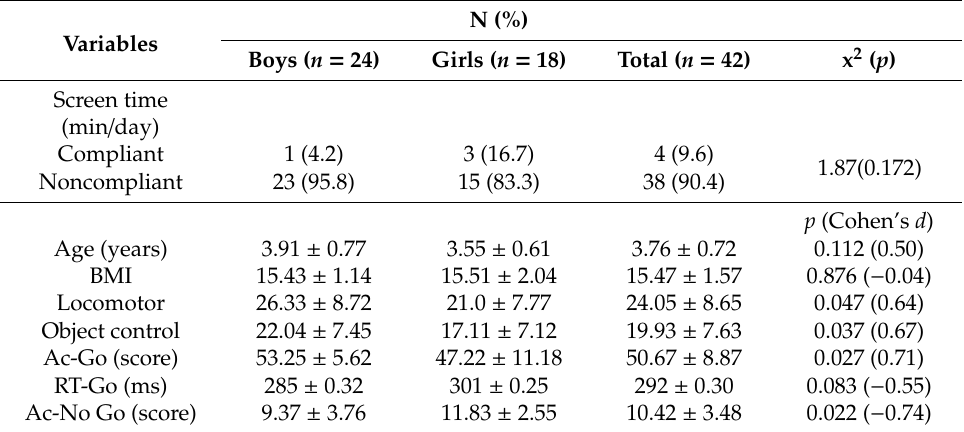
Table 1. Sample characteristics and di ff